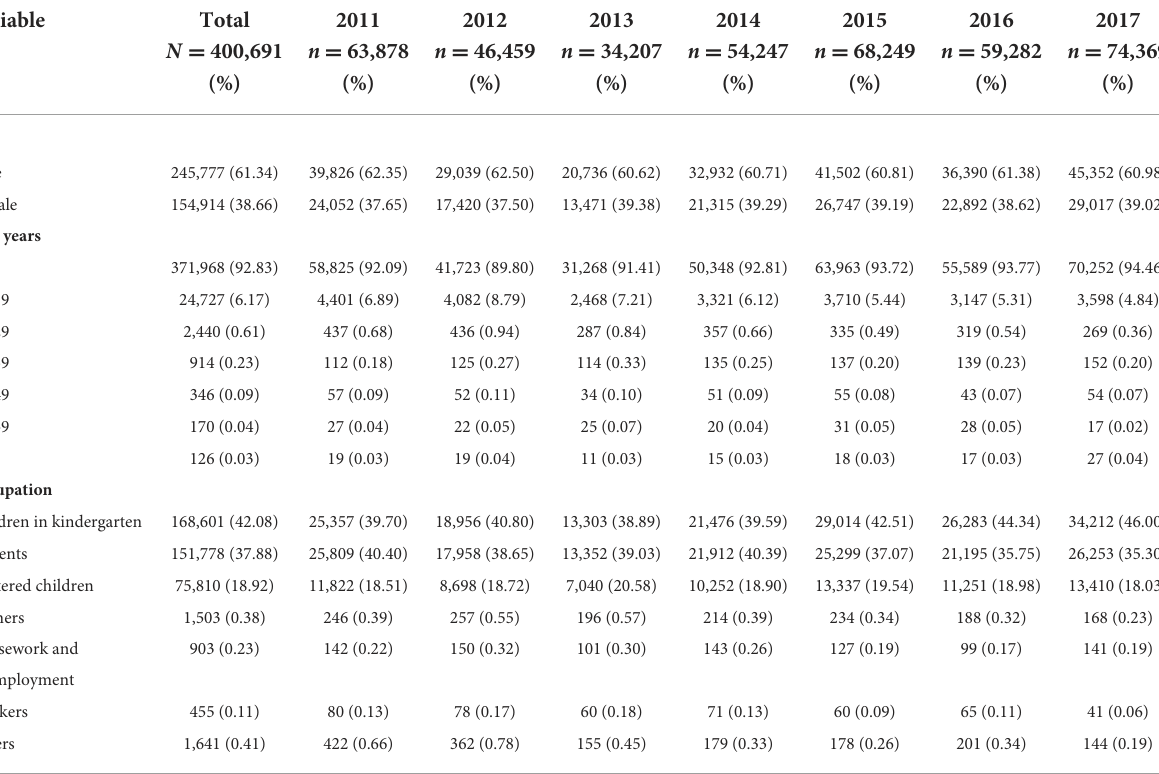
TABLE 1 Demographic and distributive features of scarlet fever in mainland China from 2011 to 2017.